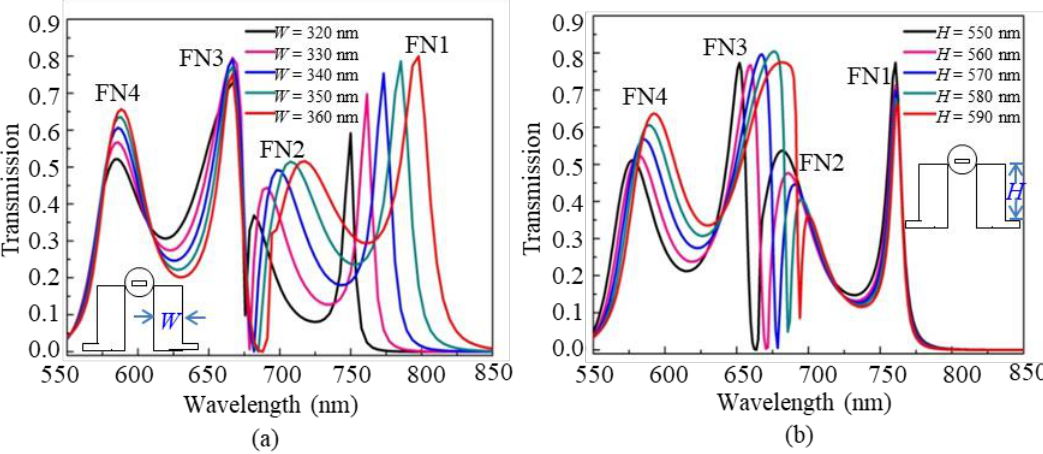
Figure 5. Transmission changes for ( a ) different width W of the rectangular cavity, and ( b ) different height H of the rectangular cavity.